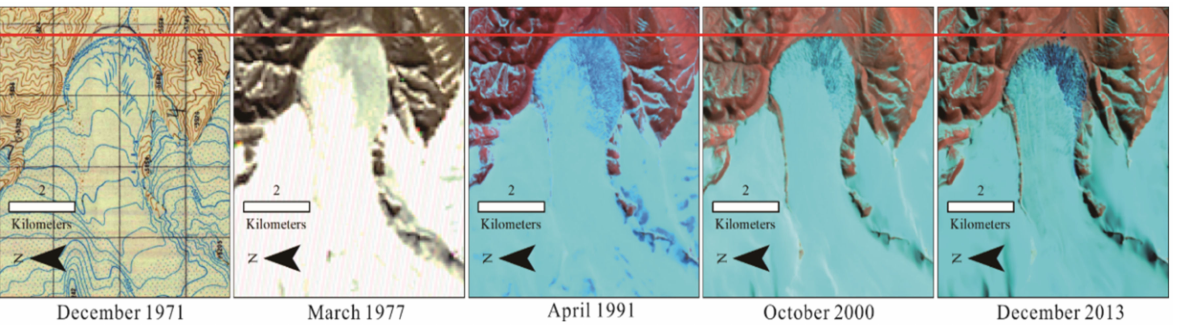
Figure A9. Changes at terminus of glacier G085885E34389N from 1971 to